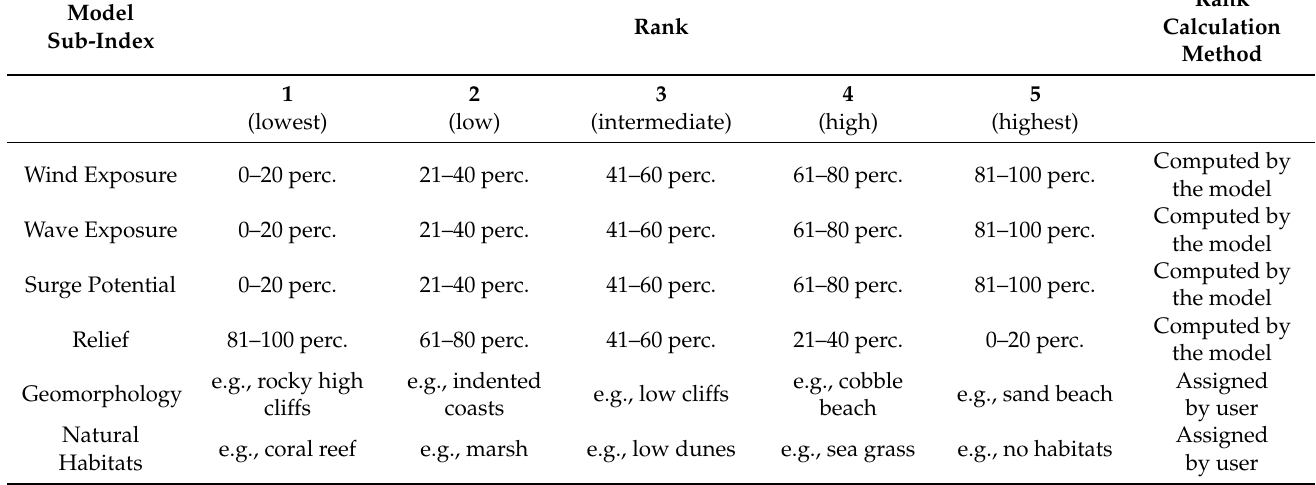
Table 2. Adaptation of the guidance ranking table for the InVEST Coastal Vulnerability model proposed by [35] [perc. = percentile]. The last column highlights the rank calculation method for each sub-index considered in the case study, differentiating between ranks computed by the model for each shore point based on intermediate outputs and ranks assigned by the model user to the different geomorphological or habitat categories present in the respective data inputs. Ranks assigned to geomorphology and habitat data inputs in this case study are reported in Tables A1 and